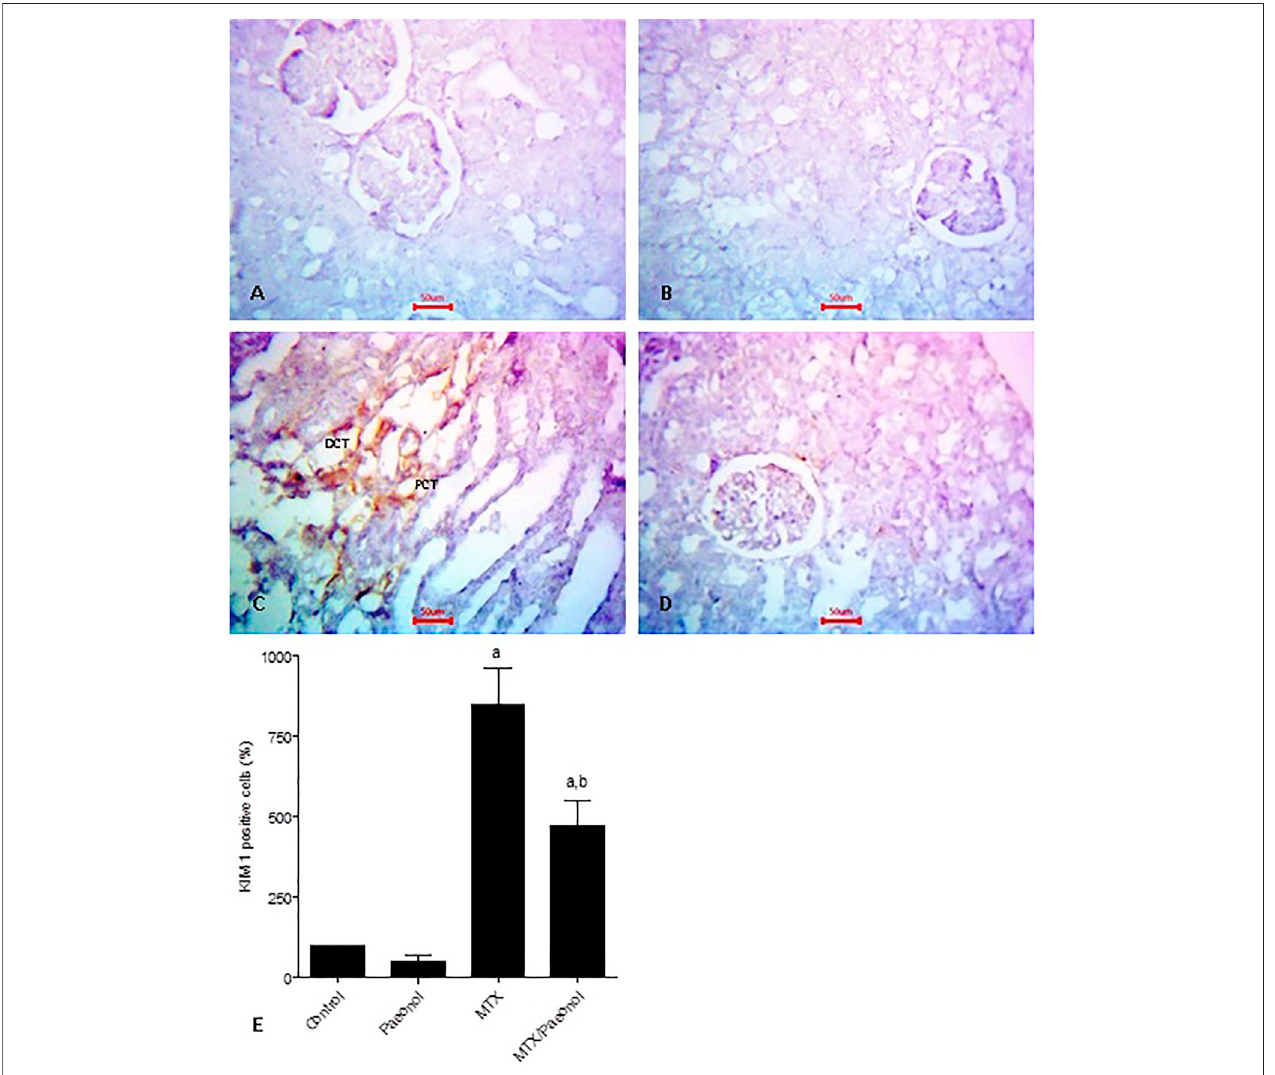
FIGURE 3 | Kidney injury molecule-1 (KIM-1) immunohistochemical staining of the kidney after methotrexate (MTX) and/or paeonol administration. KIM-1 antibody – stainedsectionsoftheratkidney(×400)from (A) control, (B) paeonol-treated, (C) MTX-treated,and (D) MTX/paeonol-treatedrats. (E) Percentofpositivecells comparedtothecontrolgroup,obtainedfromsectionsofeachanimal( n =6foreachgroup),six fi elds/section,whereresultswereconsideredsigni fi cantlydifferentwhen p < .05. a,b Signi fi cant difference compared to control or MTX groups, respectively.